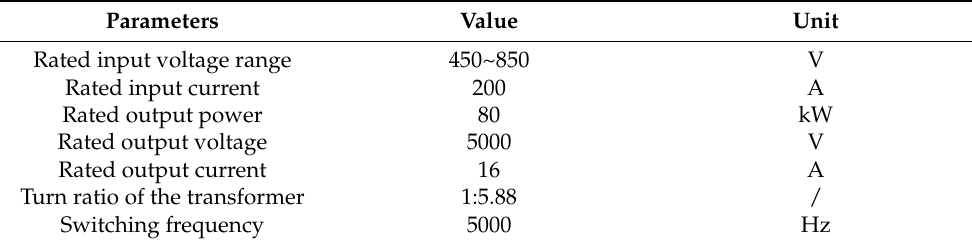
Table 1. Parameters of 5 kV/80 kW power module.